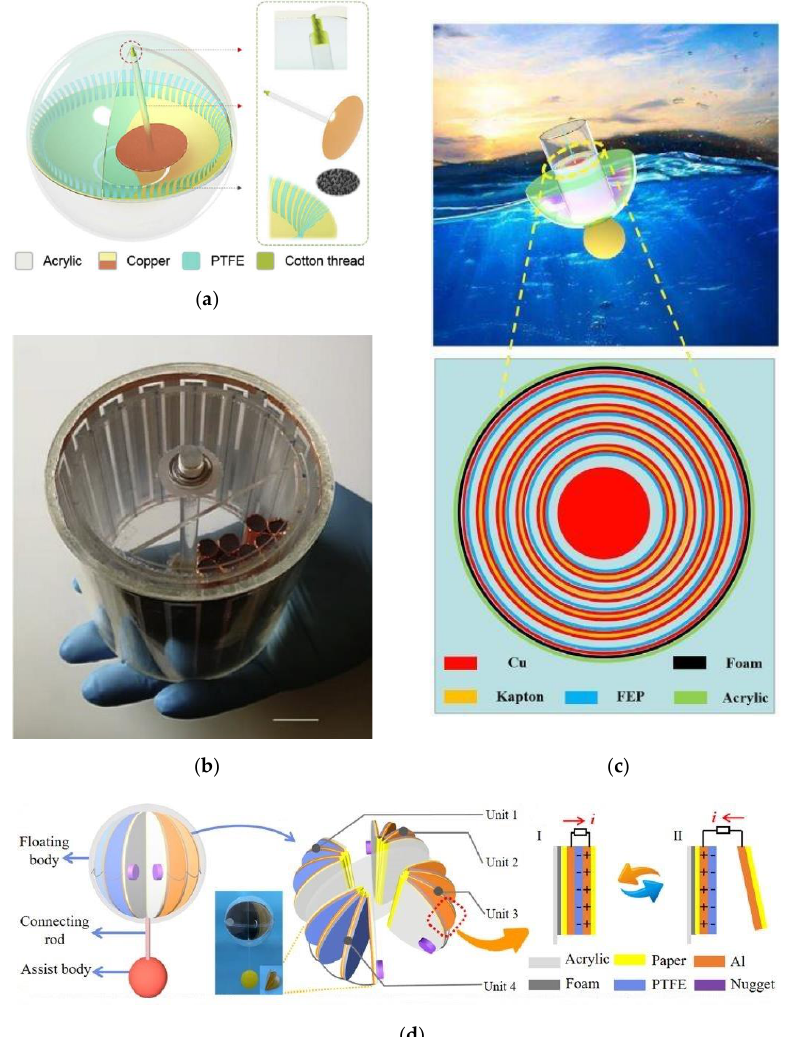
Figure 13. ( a ) Spherical pendulum triboelectric generator [97]. Reprinted with permission from Ref. [97]. Copyright 2019, Elsevier. ( b ) Cylindrical pendulum-shaped triboelectric nanogenerator [98]. Reprinted with permission from Ref. [98]. Copyright 2020, Elsevier. ( c ) Active resonance tri- boelectric nanogenerator [99]. Adapted with permission from Ref. [99]. Copyright 2021, Elsevier. ( d ) Inverted pendulum-typed triboelectric energy harvester [100]. Adapted with permission from Ref. [100]. Copyright 2022, Elsevier.